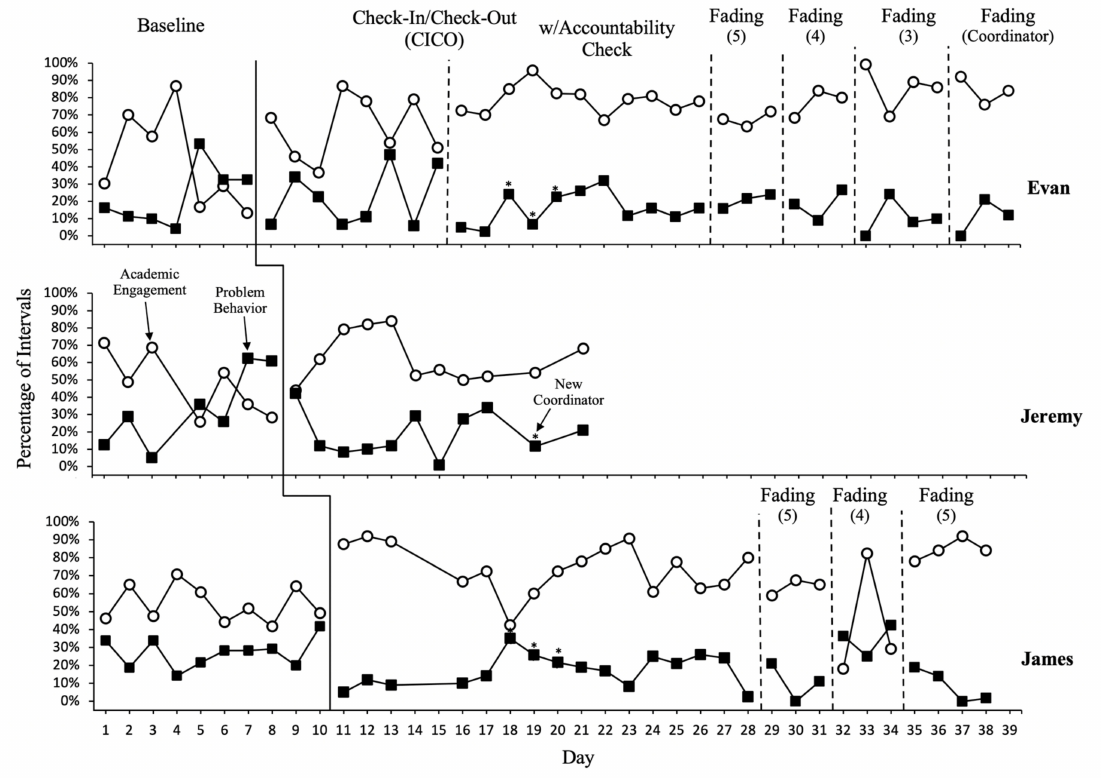
Figure 1. Percentage of intervals with academic engagement and problem behavior across conditions and students. The asterisks refer to the days when a new coordinator implemented